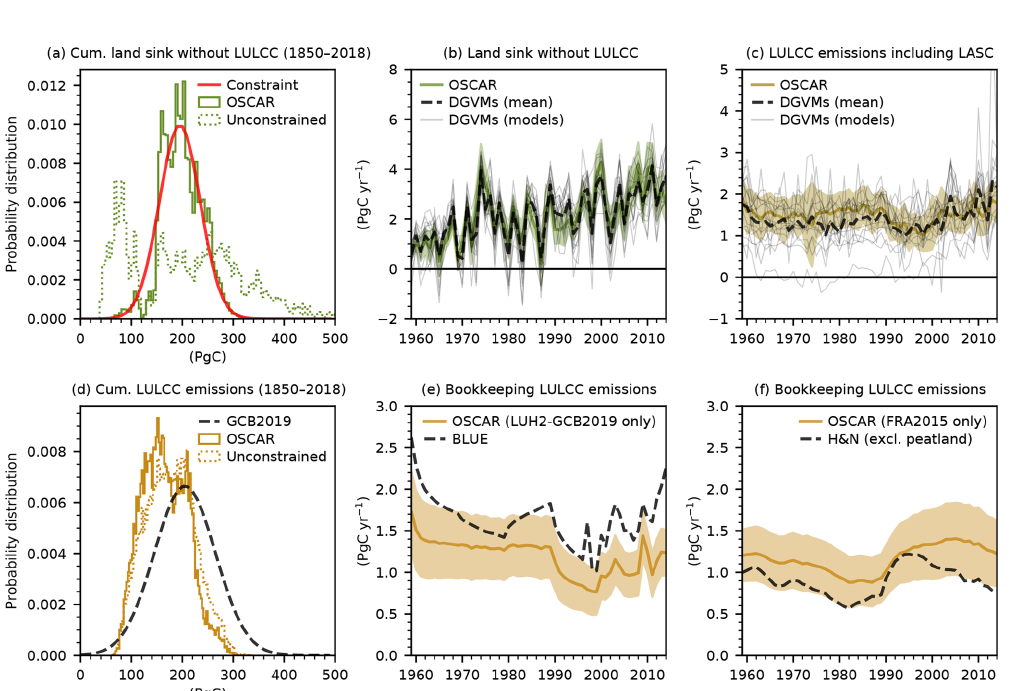
Figure A1. The effect of the alternative constraint and comparison to the GCB2019. (a) Probability distributions in the unconstrained (dotted histograms) and constrained (plain histograms) OSCAR ensembles of the cumulative terrestrial carbon sink over the 1850–2018 period in the absence of LULCC perturbation compared with the constraint (red). (b) The annual terrestrial carbon sink in the absence of the LULCC perturbation simulated by OSCAR (color), the individual GCB DGVMs (light gray), and their multi-model mean (dashed black). (c) The annual LULCC emissions deduced from the GCB DGVMs (i.e., including the LASC). (d) Probability distributions of our best-guess estimate of the cumulative LULCC emissions over the 1850–2018 period compared with the GCB estimate (dashed black). (e) Bookkeeping LULCC emissions when the model is driven by the LUH2-GCB2019 data set compared with BLUE estimates reported by the GCB2019. (f) Bookkeeping LULCC emissions when the model is driven by the FRA2015 data set compared with H&N estimates from which emissions from peatlands were subtracted. All shaded areas show the 1 σ uncertainty